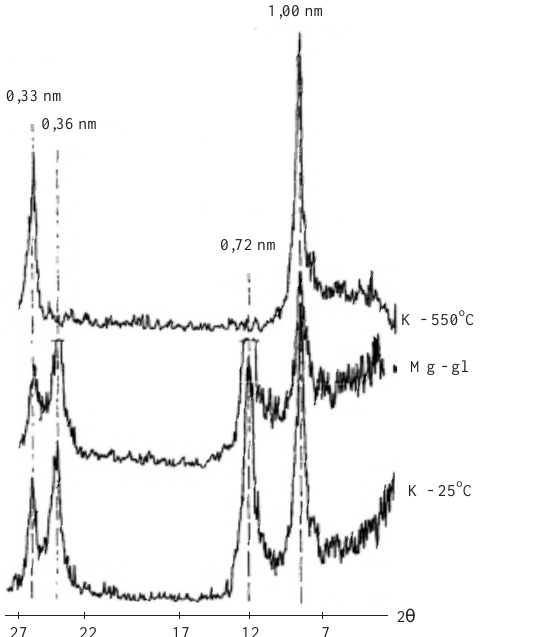
Figura 4. Mineralogia da fração argila do horizonte B do Brunizém Avermelhado. M = Mica; Ka = t